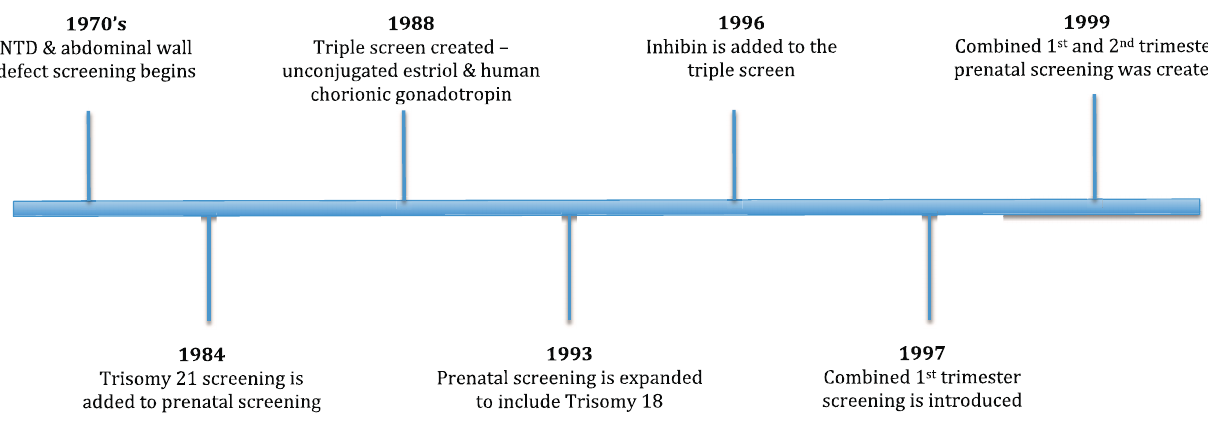
Figure 1. History of prenatal screening tests